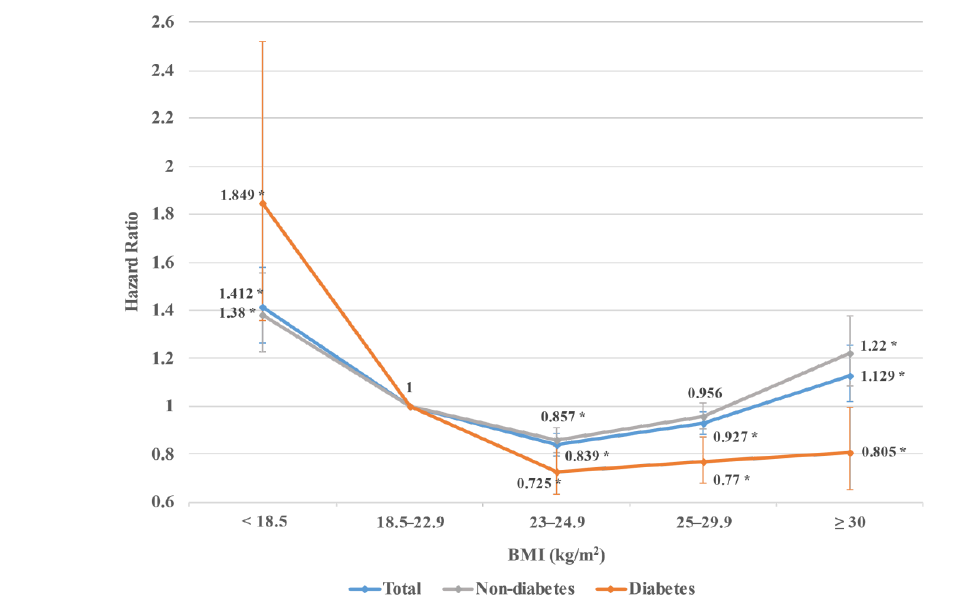
Figure 1. Adjusted hazard ratios of acute pancreatitis by BMI group according to the presence or absence of type 2 diabetes. Adjusted for age, sex, alcohol consumption, smoking, type 2 diabetes, insulin administration, hypertension, dyslipidemia, chronic kidney disease, chronic pancreatitis, regular physical activity, and low income. * Statistically significant. 3.3. Risk of Acute Pancreatitis According to Glycemic Status and BMI Category The IR (per 1000 person-years) and HR of acute pancreatitis according to five gly- cemic statuses, each further categorized by five BMI ranges are shown in Figure 2 (Sup- plementary Table S2). In the normal FPG group, the IR was highest in the obese stage II (IR 0.293). However, in the IFG or diabetes groups, the IR was highest in the underweight category and increased as glycemic status worsened from IFG to type 2 diabetes of less than five years (IR 0.466 for IFG; 0.858 for new-onset type 2 diabetes; 1.78 for type 2 dia- betes <5 years). In the group with type 2 diabetes of more than five years, IR did not in- crease further but showed a higher value than that in the group of new-onset type 2 di- abetes (IR 1.634 for type 2 diabetes ≥5 years). The underweight category in all five glycemic statuses had the highest HR of acute pancreatitis. Similar to the pattern found in IRs, the increase of overall HRs correlated the worsening of glycemic status and duration of diabetes, as exhibited in groups from IFG to diabetes of less than five years. (HR 1.381 for normal FPG; 1.805 for IFG; 2.332 for new-onset type 2 diabetes; 4.51 for type 2 diabetes <5 years). The HR in diabetes of more than five years (HR 4.135 for type 2 diabetes ≥5 years) was not higher than that in diabe- tes of less than five years, but higher than that in new-onset type 2 diabetes.